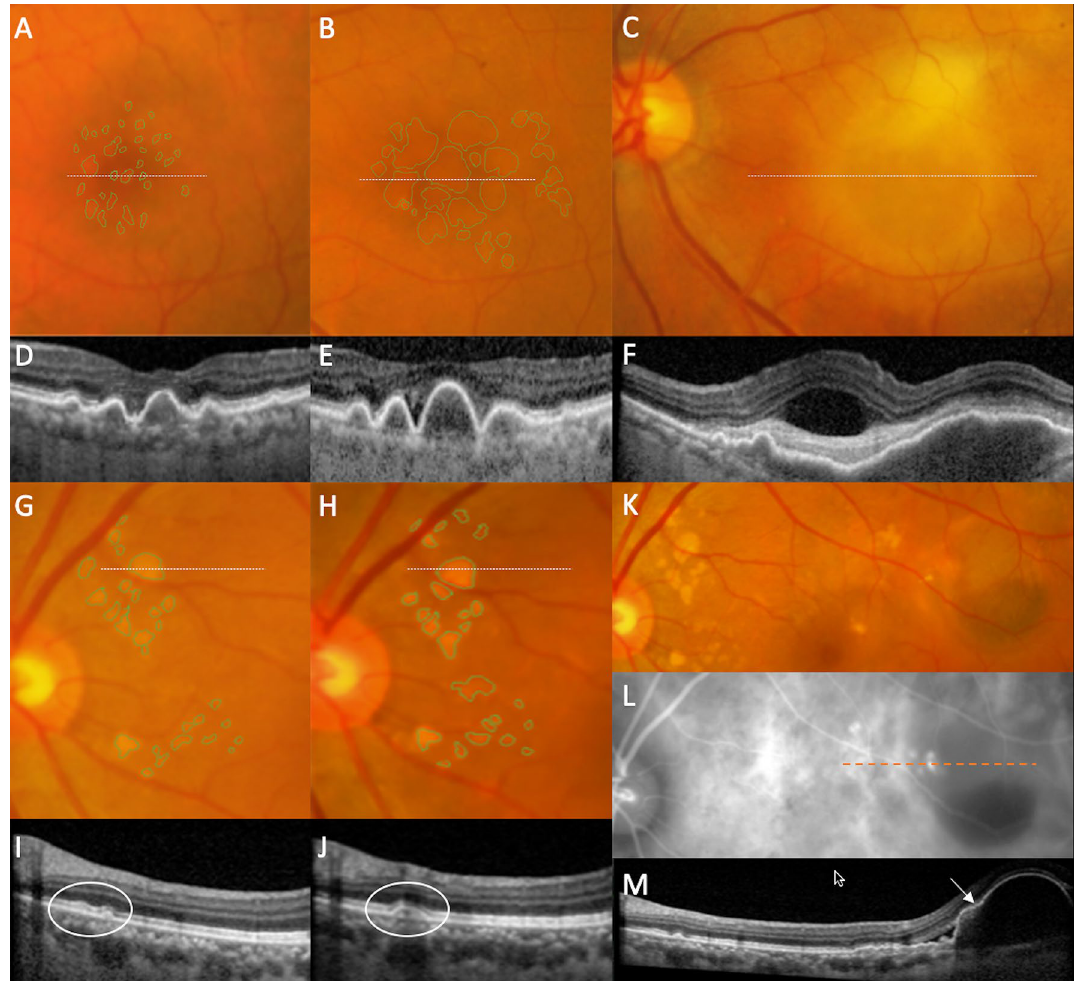
Figure 2. Progression of soft drusen ( A – F ) and pachydrusen ( G – M ) on color fundus photography (CFP) and optical coherence tomography (OCT) to incident exudative MNV. Location of OCT line scans through drusen of interest are indicated by dotted lines on the corresponding CFP. ( A – F ) In this eye with soft drusen at baseline visit (baseline total drusen area size 2.45 mm 2 ), increase in size and area of drusen was noted over a follow up period of 3 years (final total drusen area size 6.16 mm 2 ) ( A , B ). Incident exudative MNV ( C ) was noted at 10 months after previous visit ( B ). In the corresponding OCTs, there was increase in drusen height ( D , E ), followed by development of subretinal fluid, subretinal hyperreflective material and a large, irregular pigment epithelial detachment (PED) ( F ). ( G – M ) Example of progression in an eye with pachydrusen. Pachydrusen were present at baseline ( G ). These are characterized by non-confluent, ovoid or complex shapes with well- defined borders and scattered throughout the macula with no surface pigmentation. Over a follow up period of 3 years, there was mild increase the area of pachydrusen ( G , H ) (baseline total area size 0.51 mm 2 to final total drusen area size 0.66 mm 2 ). The corresponding OCTs through one are shown in ( I ) and ( J ). Haemorrhagic PED secondary to polypoidal choroidal vasculopathy (PCV) was noted 8 months after the last documented CFP ( K ) and confirmed on ICGA ( L ). OCT line scan through the polypoidal lesion (indicated by the arrow on OCT and orange dotted line on ICGA) ( M ). The area of exudative MNV did not colocalise to the areas of